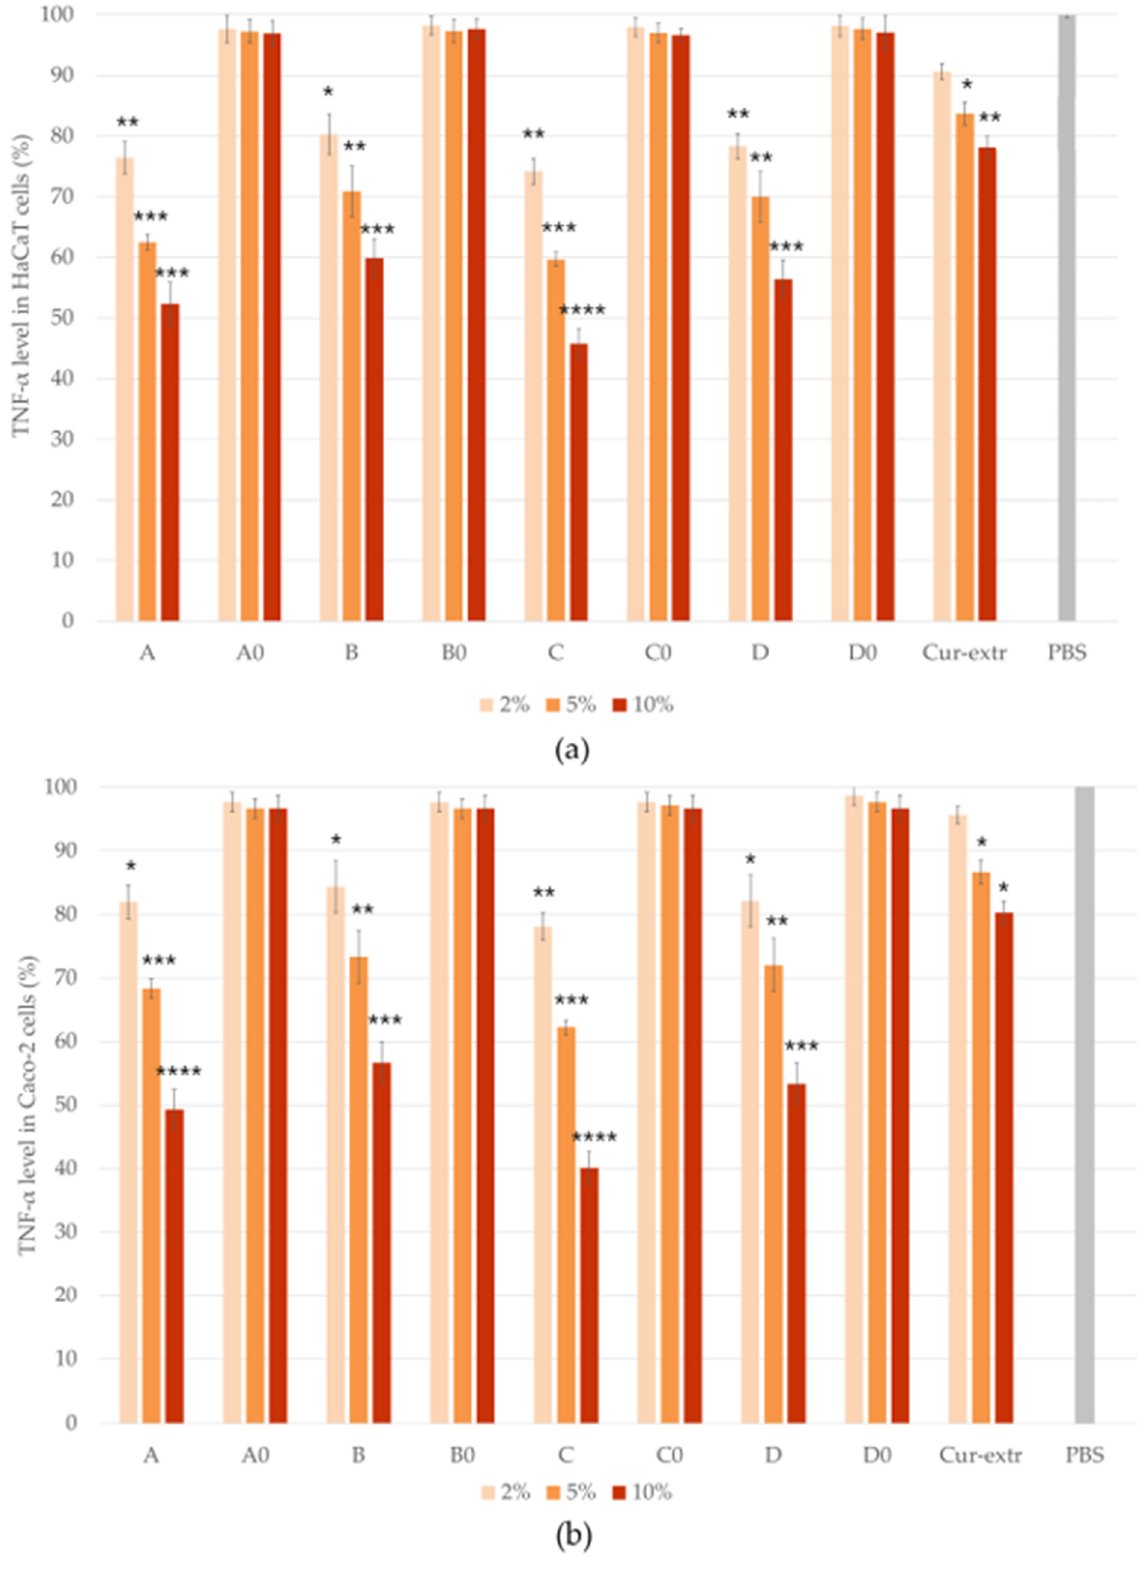
Figure 10. Results of human TNF- α ELISA tests on HaCaT ( a ) and Caco-2 ( b ) cells. Ordinary one-way ANOVA with Dunnett’s multiple comparison test was performed to compare the different formulations with PBS. The *, **, ***, and **** indicate statistically significant differences at p < 0.05, p < 0.01, p < 0.001, and p < 0.0001.